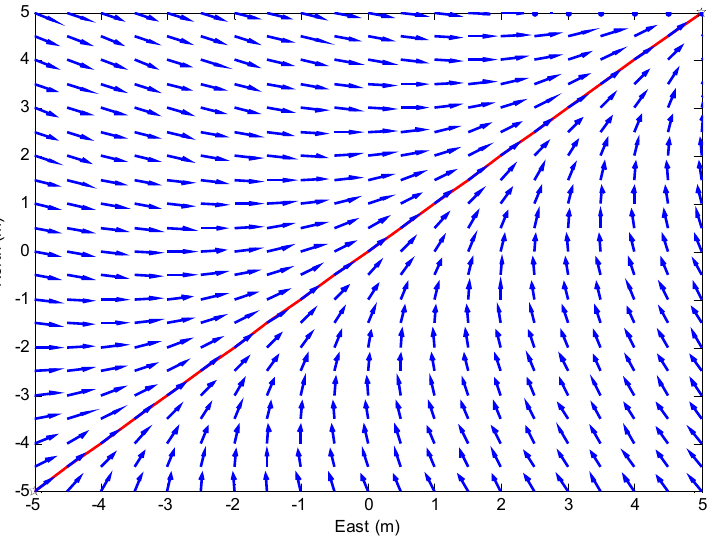
Figure 6. Vector space around the predefined path (red line).